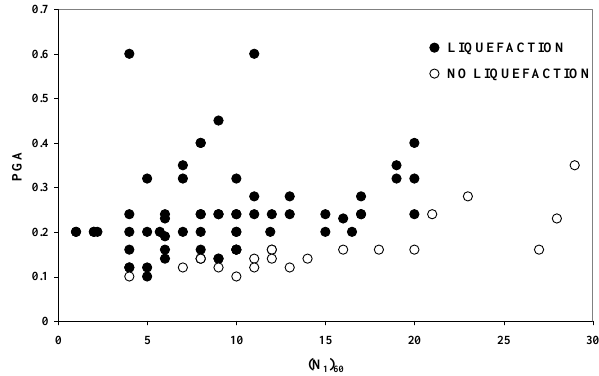
Figure 16. Plot between PGA and (N1)60 for global data using radial basis function. Fig. 16. Plot between PGA and (N 1 ) 60 for global data using radial basis